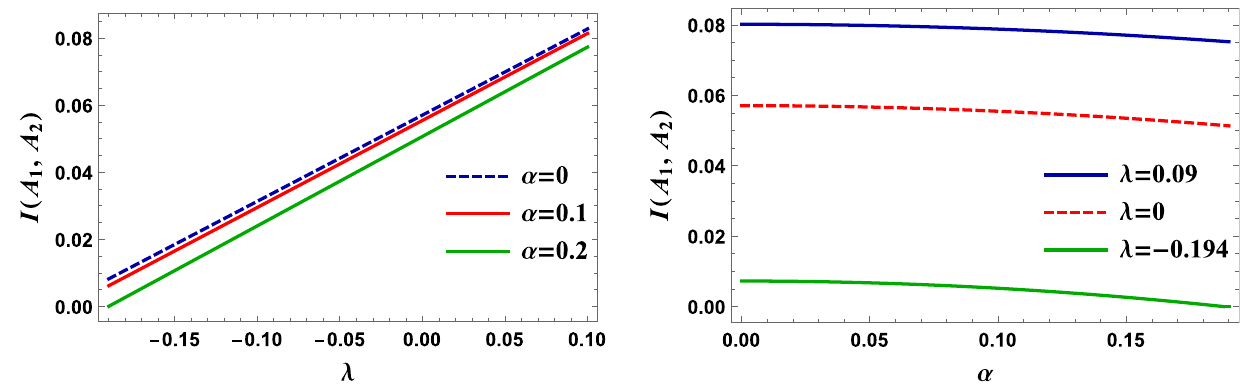
Fig. 2 Left plot: the behavior of mutual information as a function of GB parameter for different fixed values of α . Right plot: the behavior of mutual information as a function of momentum relaxation parameter for different fixed values of λ . It is noted that in both of the figures we set (cid:3) = 1 and h = 0 . 7